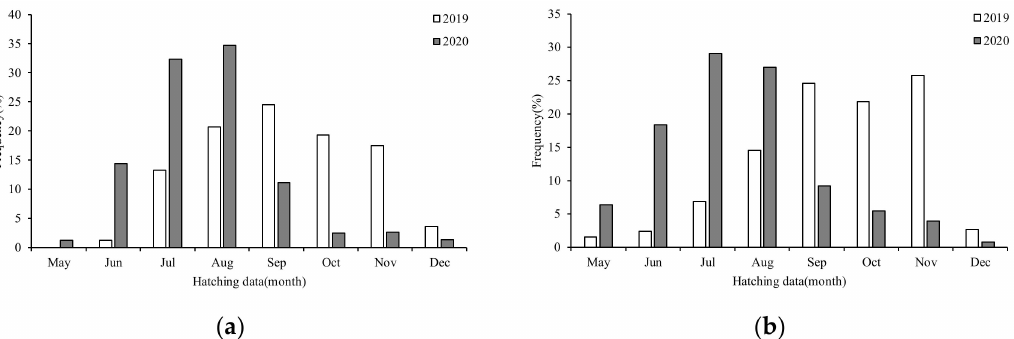
Figure 8. Hatching date frequency distribution of S. oualaniensis of different sexes in different years: ( a ) female; ( b ) male.